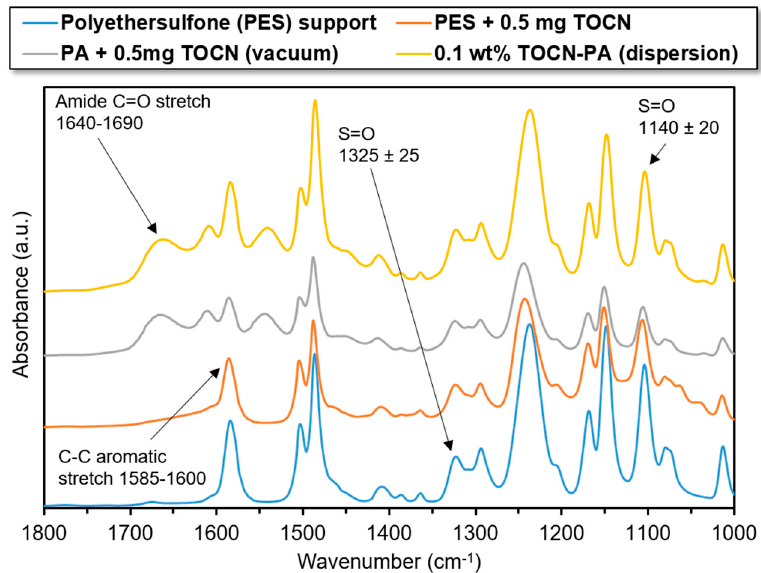
Figure 4. FT-IR scans (wave numbers 1000–1800 cm − 1 ) of polyethersulfone (PES) support material, PES with 0.5 mg TOCNs deposited, and thin film nanocomposite (TFN) polyamide membrane with 0.5 mg TOCN loading.